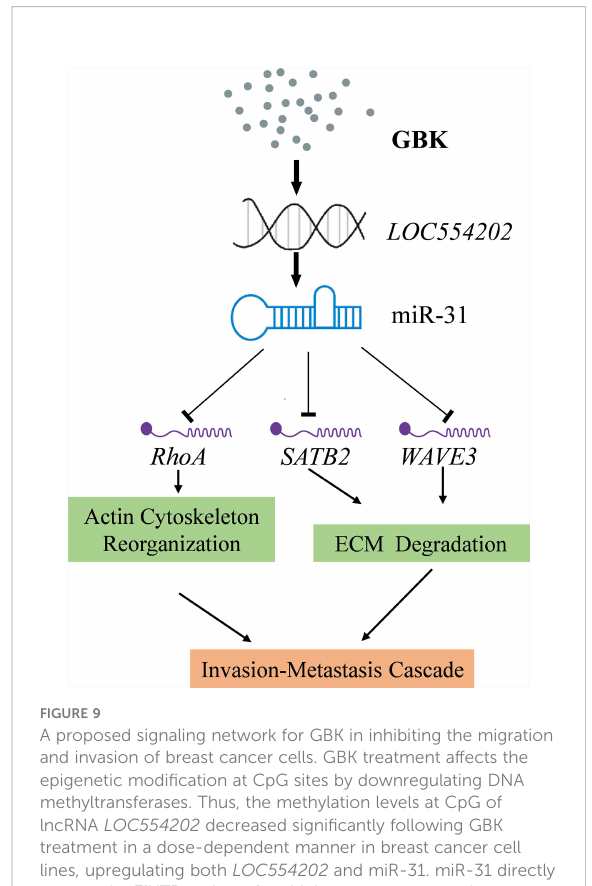
FIGURE 9 A proposed signaling network for GBK in inhibiting the migration and invasion of breast cancer cells. GBK treatment affects the epigenetic modi fi cation at CpG sites by downregulating DNA methyltransferases. Thus, the methylation levels at CpG of lncRNA LOC554202 decreased signi fi cantly following GBK treatment in a dose-dependent manner in breast cancer cell lines, upregulating both LOC554202 and miR-31. miR-31 directly acts on the 3 ’ UTR region of multiple target genes, such as RHOA , SATB2 , and WAVE3 , which playing roles in cancer cell invasion, migration, and proliferation. GBK treatment impairs the expression of RhoA, SATB2, and